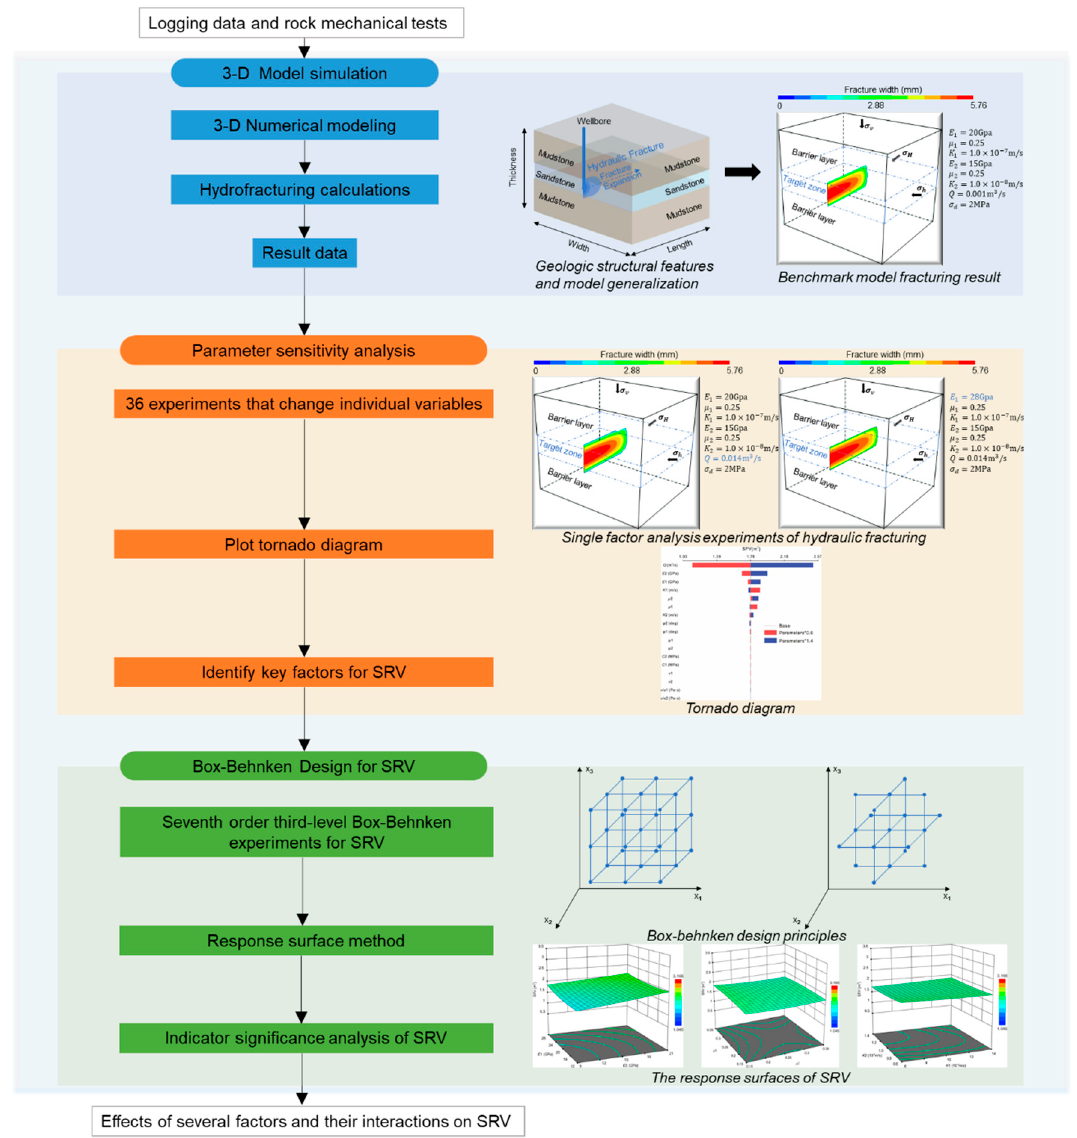
Figure 1. Flow chart of stimulated reservoir volume (SRV) analysis program is divided into three modules: (1) establishment of a fully three-dimensional model based on logging data and rock mechanics tests; (2) identification of the main control factors according to the simulation results; (3) conduction of Box–Behnken design on SRV, then analyze the effects of several factors and their interactions with the response value.